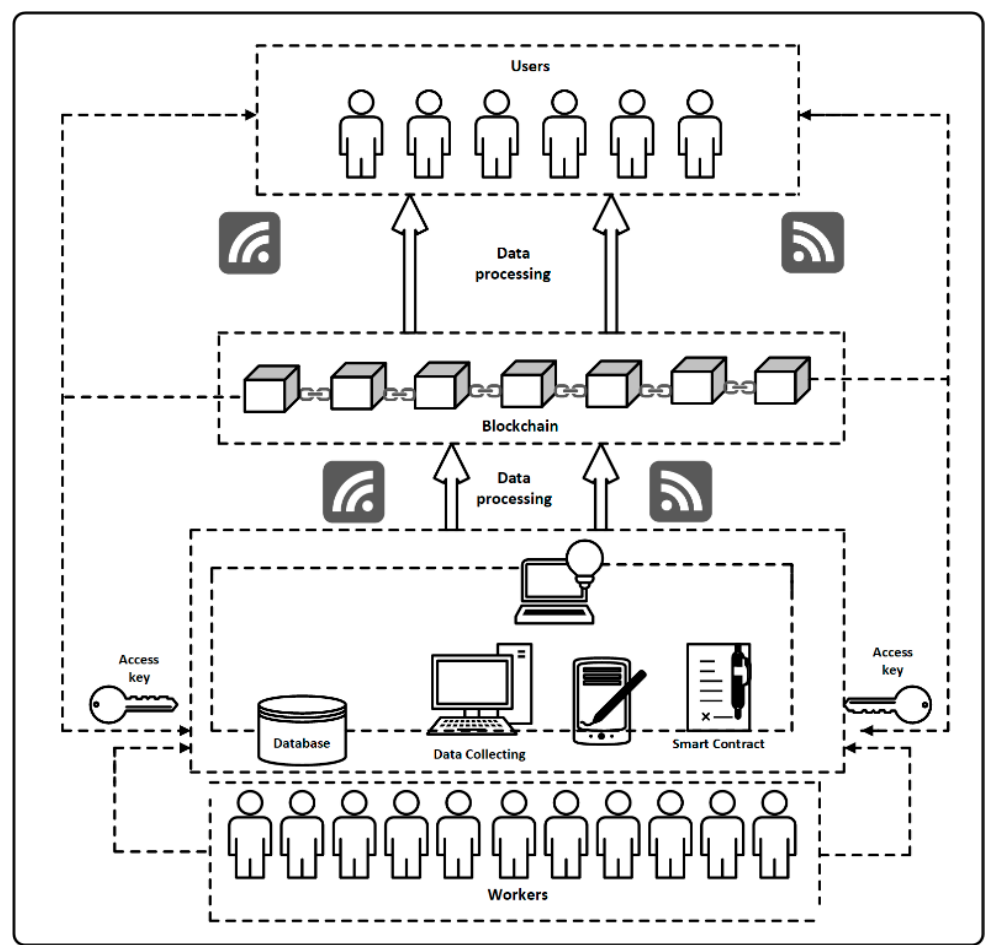
Figure 10. The process of data circulation containing information about employee competencies in blockchain technology.